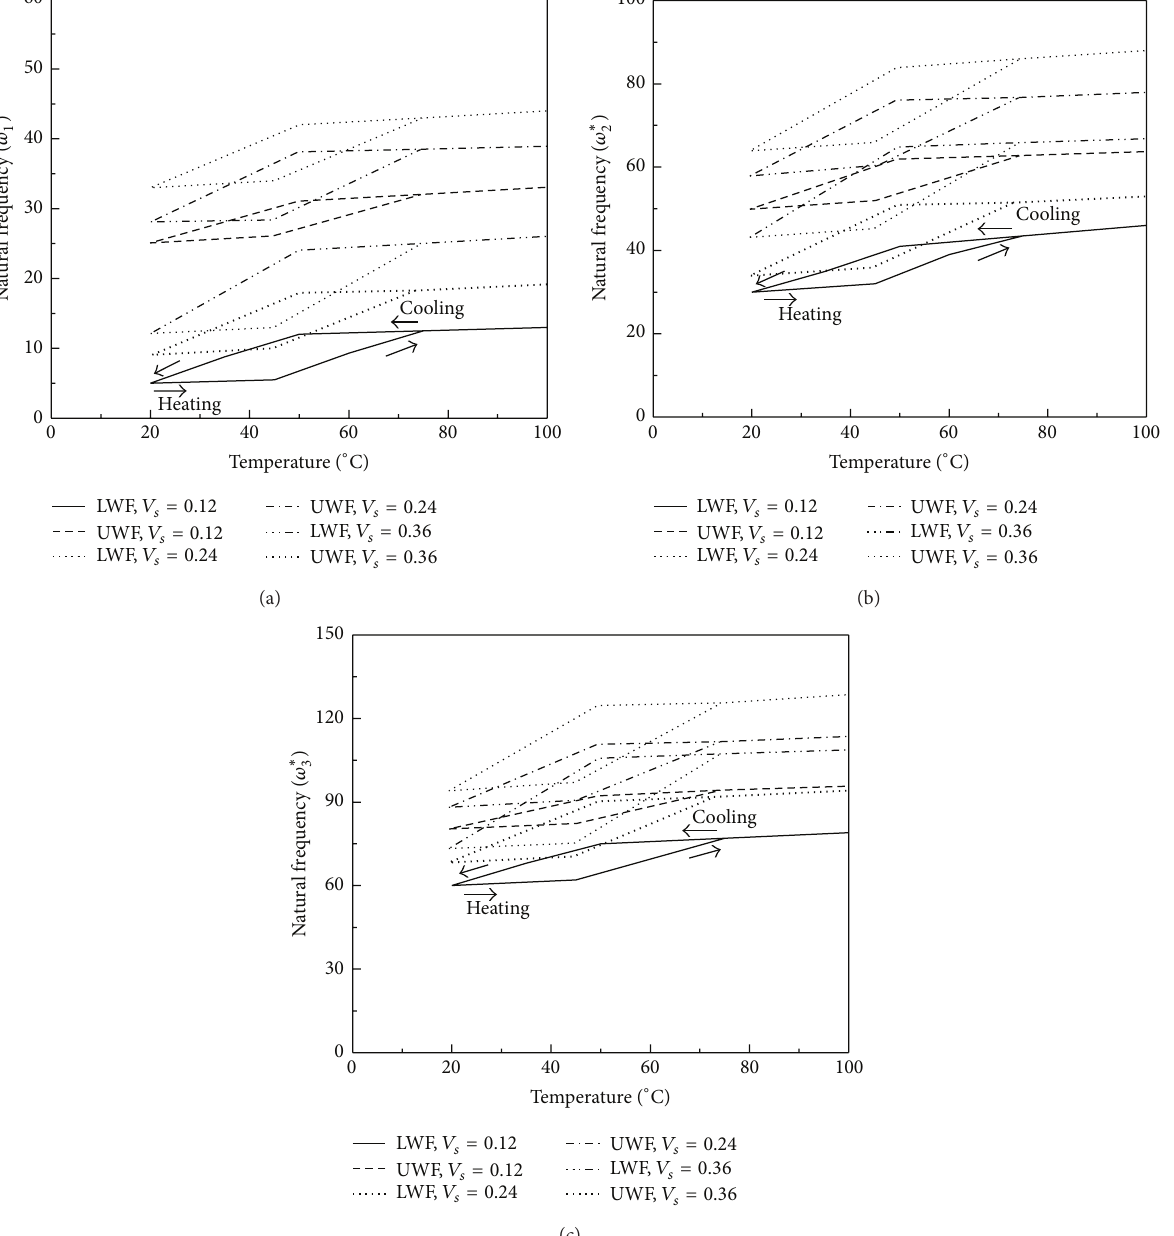
Figure 4: The first three natural frequencies versus temperature for different SMA wire fractions ( Ω ∗ = 5 rad/s; 𝜃 = 30 ∘ ; 𝜀 0 = 0.067